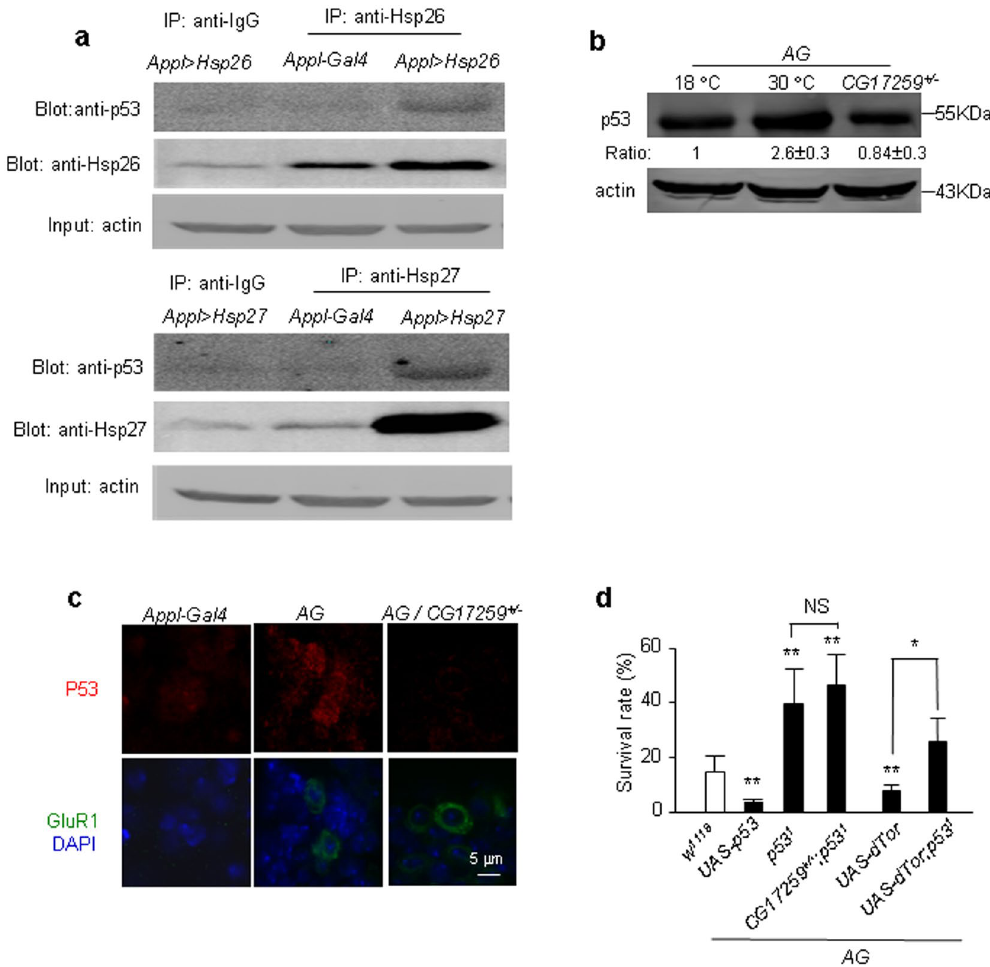
Figure 4. Characterization of p53 in the AG flies. ( a ) Co-immunoprecipitation of Hsp26/Hsp27 with p53. The homogenized fly heads were immunoprecipitated with anti-Hsp26 or anti-Hsp27 antibodies and probed with anti-Hsp26, anti-Hsp27, anti-p53 antibody, with anti-IgG as a control. The input of actin is the protein loading control. The genotypes of flies are indicated on the image. Trial n = 2. ( b ) Accumulation of p53 in the AG adult flies. The control ( AG flies at 18 °C) p53 protein level is set as 1, and the indicated genotype flies relative to the control are shown. Trial n = 3. ( c ) Accumulation of p53 in the larval AG brain. The images show immunostaining with anti-p53 and anti-GluR1 antibodies. The nuclei are stained with DAPI. The result showed that the 53 protein (the red channel) was lower in the control ( Appl-Gal4 ) ventral nerve cord of larval flies; whereas p53 protein level was higher in the AG flies, especially in neurons with higher GluR1 expression (the green channel). Trial n = 2. ( d ) Effect of p53 on AG fly survival. The survival rate of indicated genotype of flies is shown. Trial n =